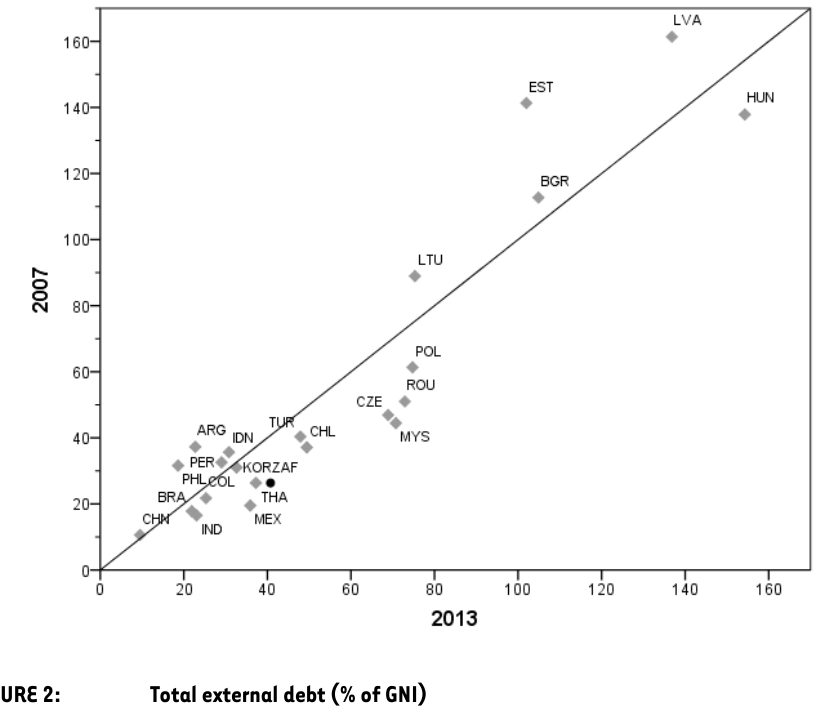
FIGURE 2: Total external debt (% of GNI) Source: Authors’ depiction of data from The World Bank: World Development